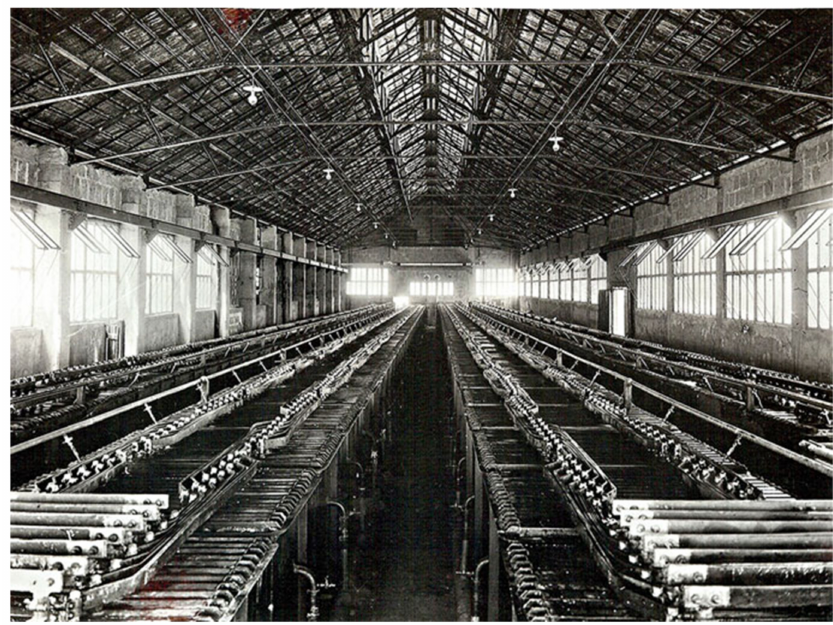
Figure 4. Electrolyzers in the Sabiñ á nigo ammonia factory in Spain, constructed in 1925. Courtesy Casale